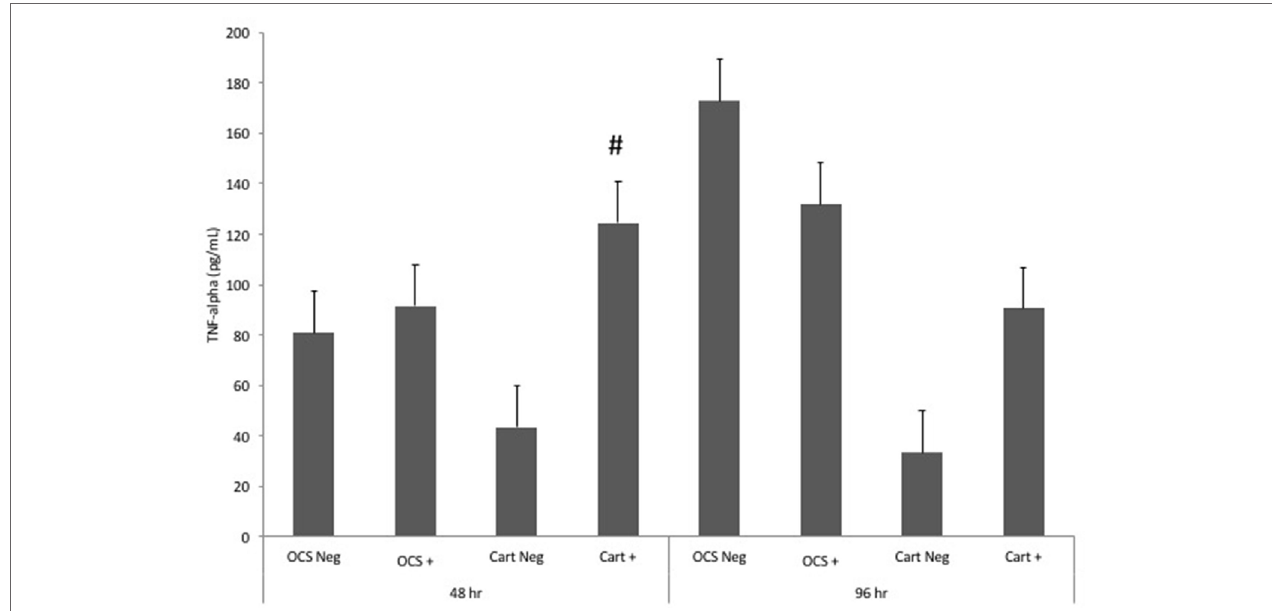
FigUre 2 | Mean ± SE concentrations of tumor necrosis factor-alpha (TNF-alpha) in media samples of cultures containing osteochondral and synovial explants (OCS) or cartilage explants alone (Cart) that were unstimulated (Neg) or stimulated with IL-1 (10 ng/mL; + ) at 48 and 96 h after initiation of treatments. # Within a time, the fold increase in TNF-alpha concentration between unstimulated and stimulated cultures is significantly different between culture types.